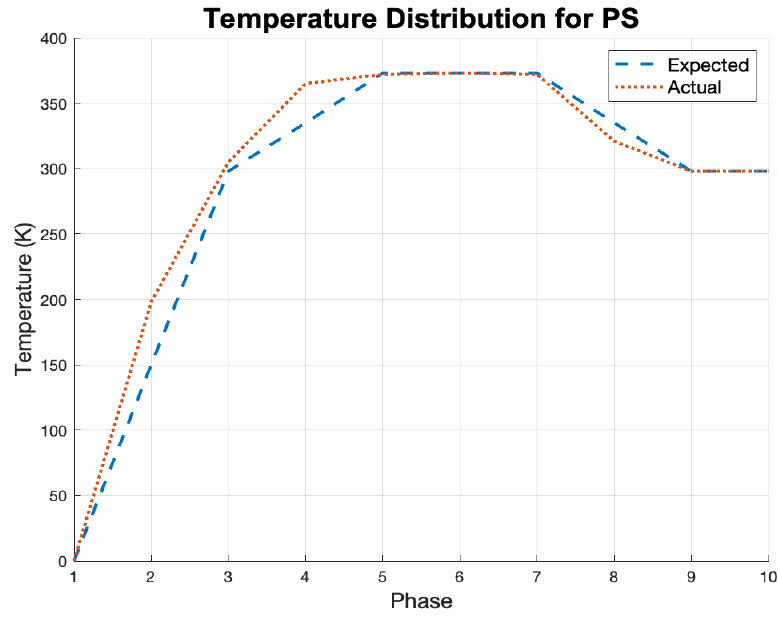
Figure 3. Temperature distribution of molecular dynamics (MD) NIL process.